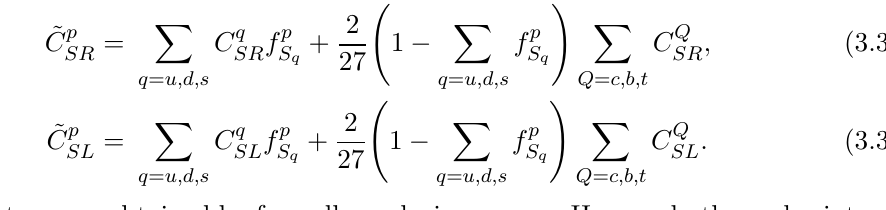
Table 4 . Numerical values of the hadronic matrix elements at (cid:22) = 1 TeV [167, 168]. where p and n denote a proton and a neutron respectively,